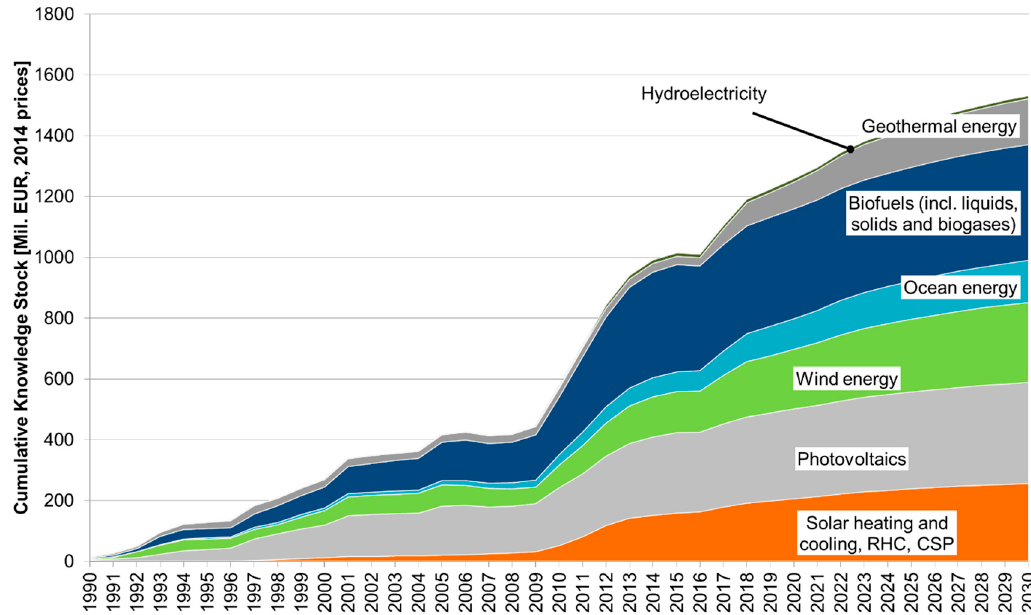
Figure 7. Cumulative RES knowledge stock induced by public R&D expenditures of the EC (Mil. EUR, BAU scenario) (2014 prices and exc. rates; knowledge depreciation, 10%; time lag, three years).